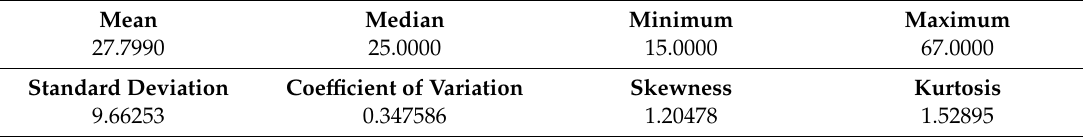
Table 3. Descriptive statistics-for observations from sample n = 1159 for the Age